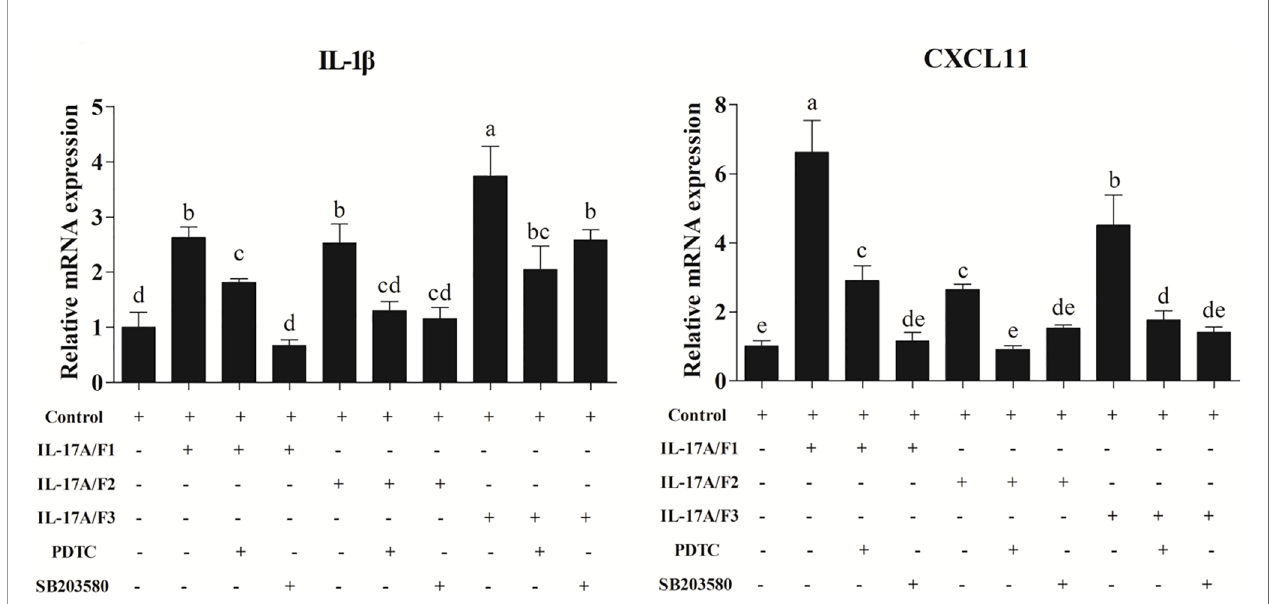
FIGURE 9 | Recombinant Pf _IL-17A/F1, 2 and 3 proteins promoted IL-1 b and CXCL11 mRNA expression in PBLs via MAPK and NF- k B pathway. PBLs were treated with 500 ng/mL r Pf _IL-17A/F1, 2 and 3 for 6 h in the presence (+) or absence (-) of different inhibitors (PDTC and SB203580). The mRNA levels of IL-1 b and CXCL11 were determined by qPCR. The PBLs were isolated from four individuals of yellow cat fi sh and were mixed equally, and the pooled sample was further divided into ten experiment units for different experimental treatments. Columns represent the means for each treatment ( n = 3). Error bars represent standard error of the means. Different letters above the bars indicate signi fi cant difference among/between the means (One-way ANOVA and Duncan test, P <